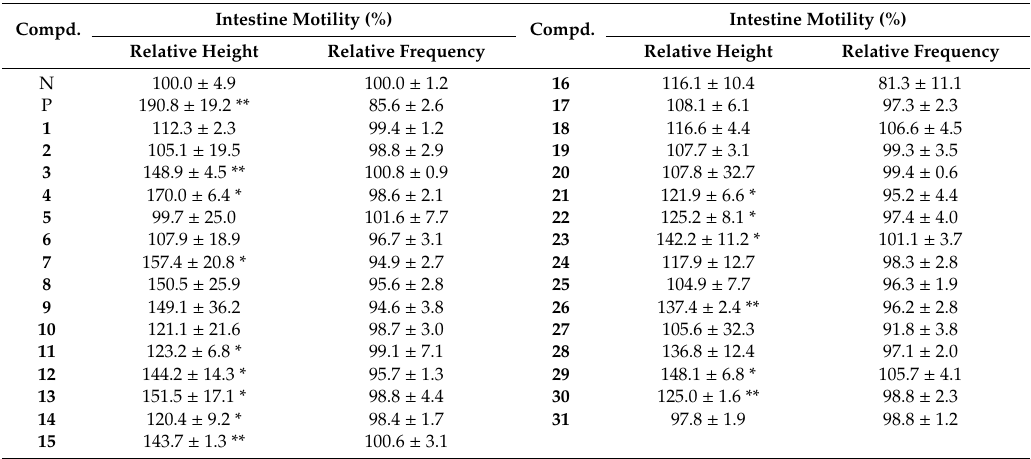
Table 3. Inhibitory e ff ects of compounds 1 – 31 on motility of mouse isolated intestine tissue. Intestine Motility (%) Intestine Motility (%) Compd. Compd. Relative Height Relative Frequency Relative Height Relative